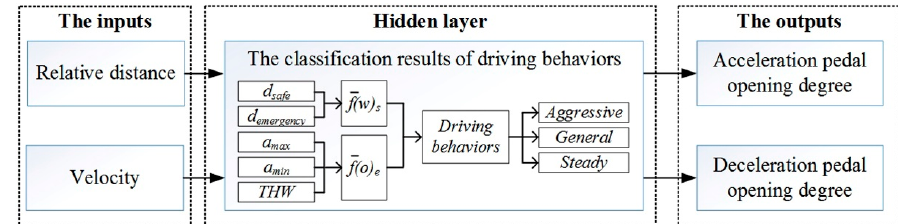
Figure 11. The architecture of linear neural network based on fuzzy classification Algorithm.